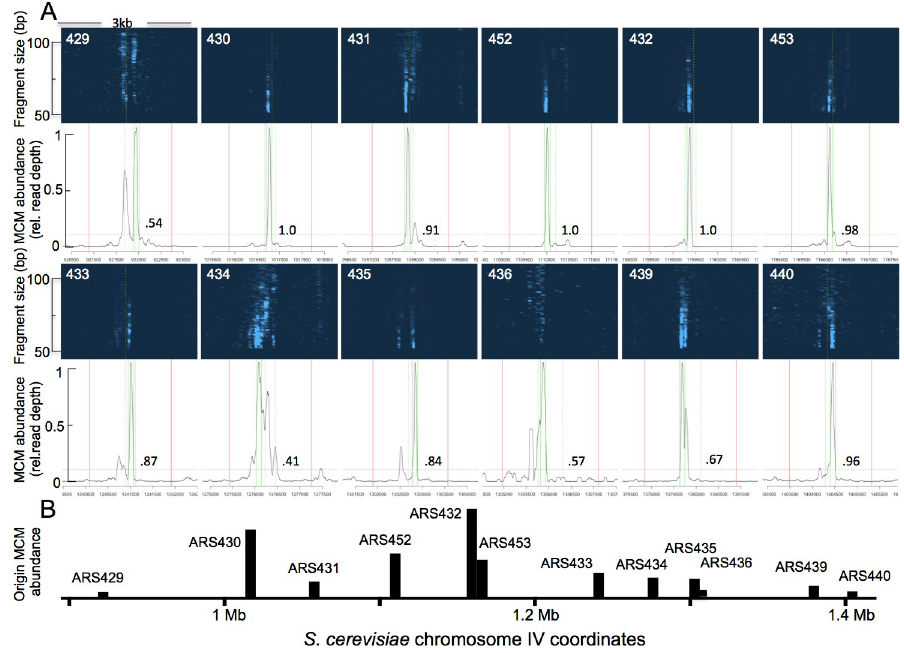
Fig 4. MCM distribution at 12 consecutive origins on S . cerevisiae chr. IV. (A) 3 kb stretches centered on each of the 12 ARSs in a 0.5 Mb region of chrIV. Top panels show genomic position on X axis and fragment length on Y axis, with read depths represented by color intensity. When an ACS sequence is indicated in SGD, it is depicted with a dashed vertical yellow line. White numbers on blue background indicate ARS numbers, as assigned in SGD. Black traces below blue figures show quantitation of fragments in the 50–100 bp range. Vertical lines mark 60 base pairs on each side of the peak of MCM signal (dotted green), origin boundaries (dotted black) and 800 bp on each side of the origin boundaries (solid red). The fraction of MCM signal arising from a single DH, indicated by the black numbers, is assessed as the fraction of signal within the green lines divided by signal within red lines, using 10% of the height of the MCM peak (horizontal dotted black line) as the cutoff between "signal" and "noise". (B) Chromosomal distribution and relative MCM signal from the 12 origins in A.